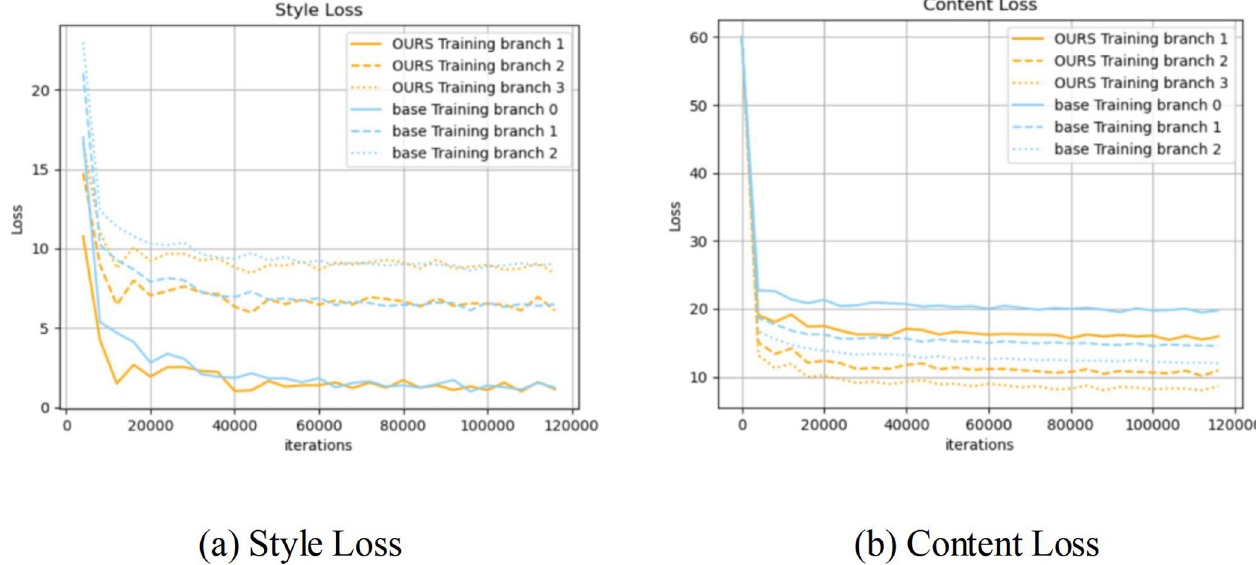
Fig 6. Comparison of the training curve between the network when using hybrid dilated convolution and the baseline model network.